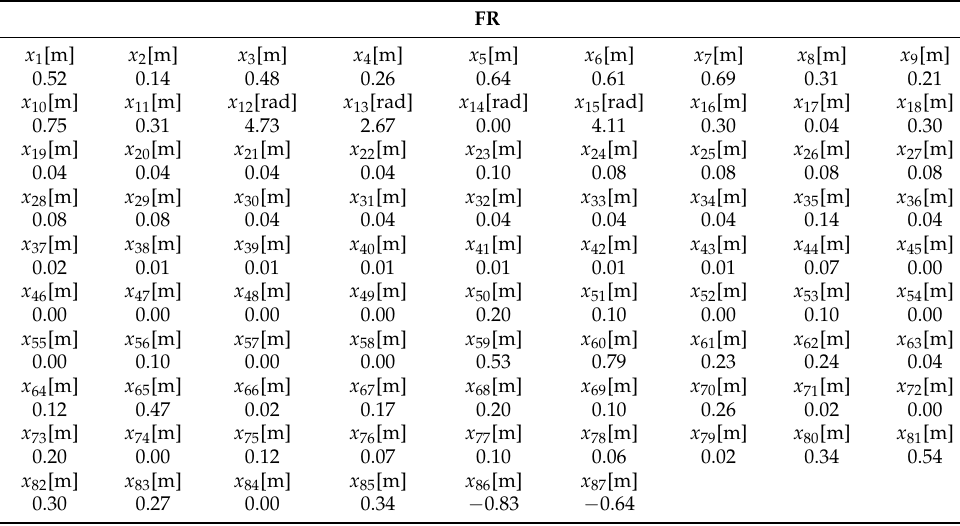
Table A28. Optimum design variables obtained by the best and the worst CHTs for study case 3: Eight-bar linkage